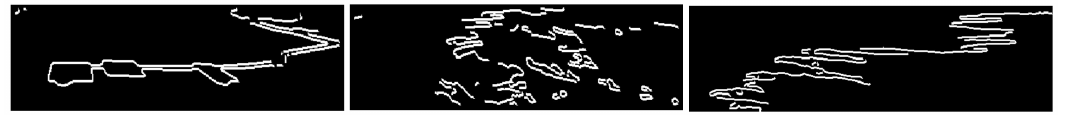
Figure 16. Ground-truth shadow edge maps of images in Figure 12.